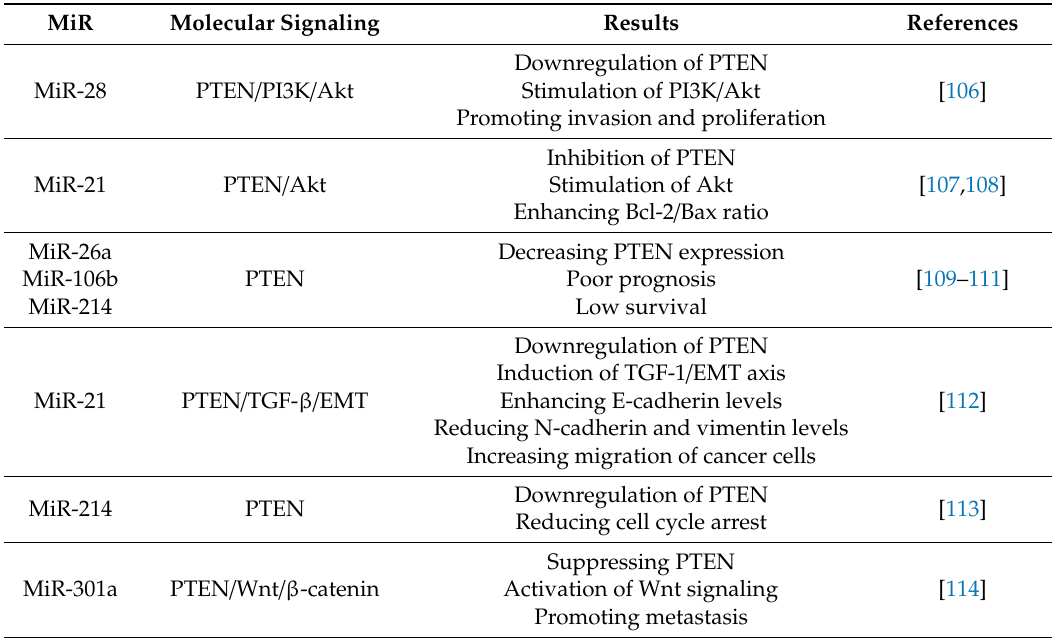
Table 1. Regulation of PTEN and its downstream targets by miRs in gastric cancer (GC) cells.